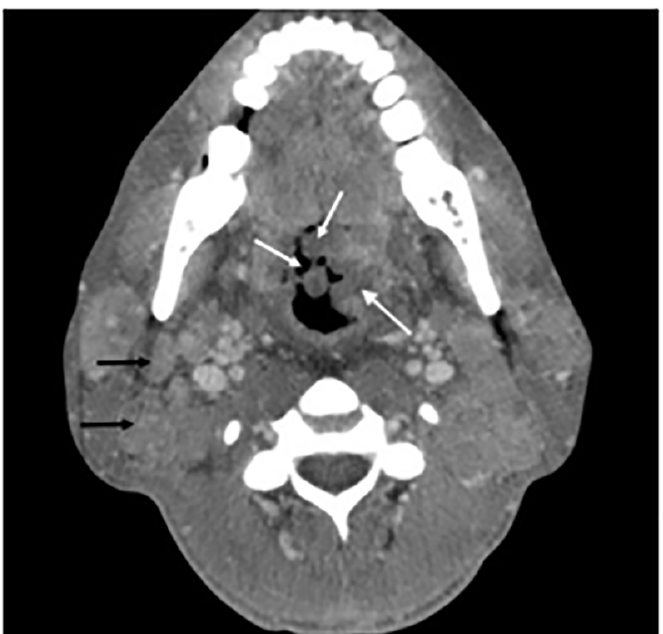
Image 3 . Axial computed tomography soft tissue neck showing diffuse nodular thickening of mucosal surfaces (white arrows) and extensive cervical lymphadenopathy (black